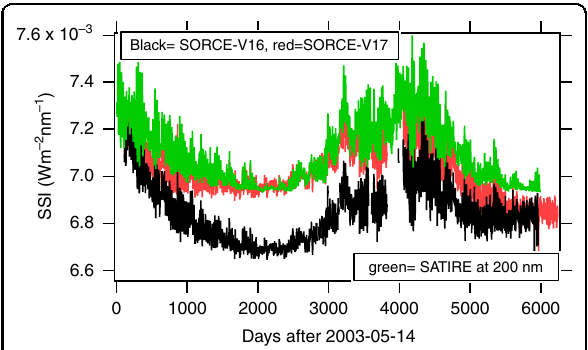
Fig. 5 Comparison between time series measured by SORCE V16, V17, and SATIRE at 200